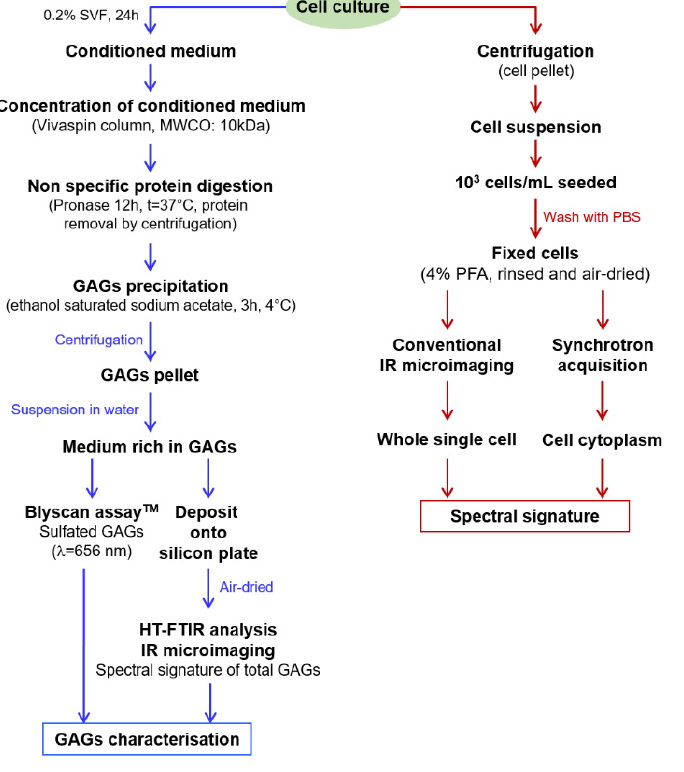
Figure 7. The workflow of the preparation of cells and their conditioned media for biochemical and spectral analyses. spectral